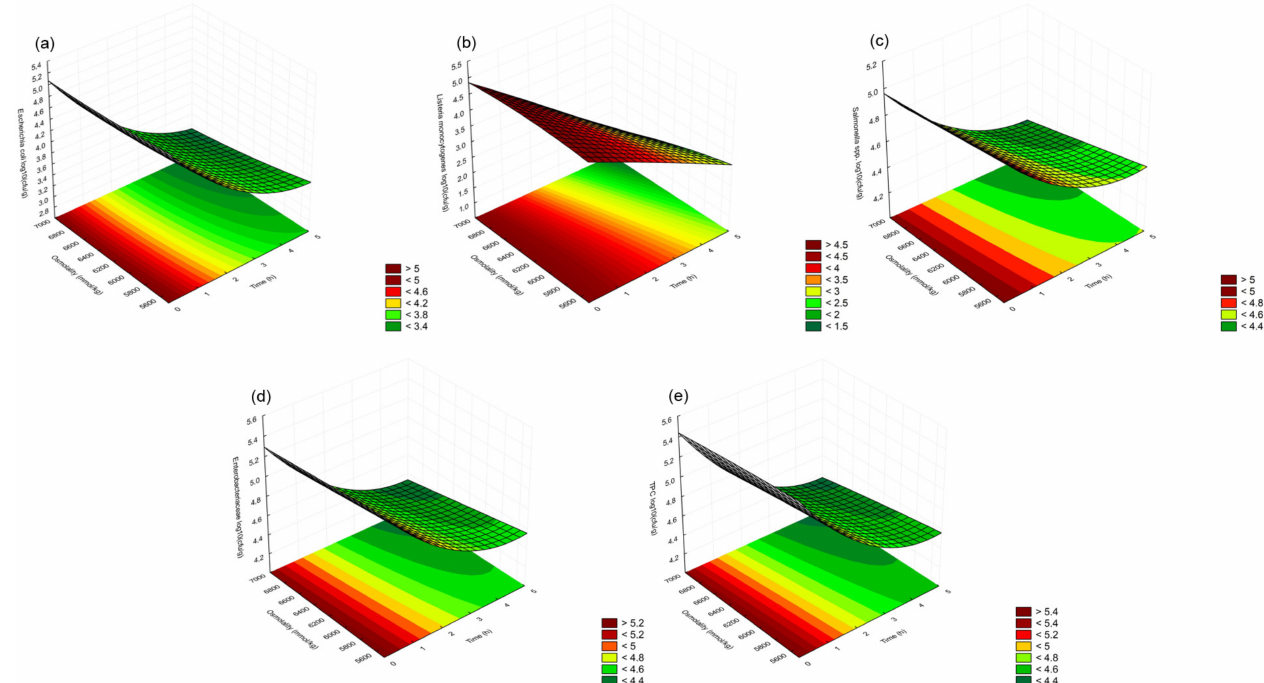
Figure 1. Graphical presentation of mathematical modeled dependence of ( a ) E. coli ; ( b ) L. mono- cytogenes , ( c ) Salmonella spp.; ( d ) Enterobacteriaceae, and ( e ) TPC numbers in molasses at different exposure time and of different